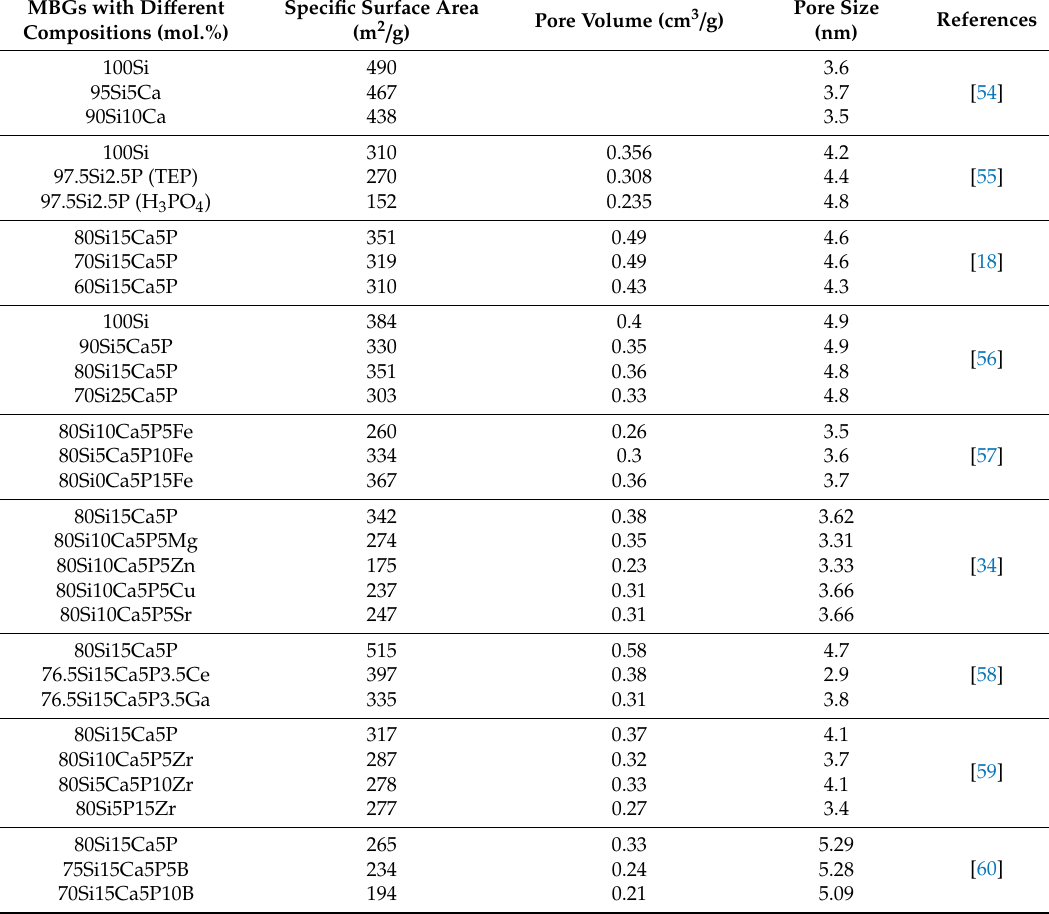
Table 2. The e ff ect of composition on the characteristics of mesopore structures [7]. MBGs with Di ff erent Compositions